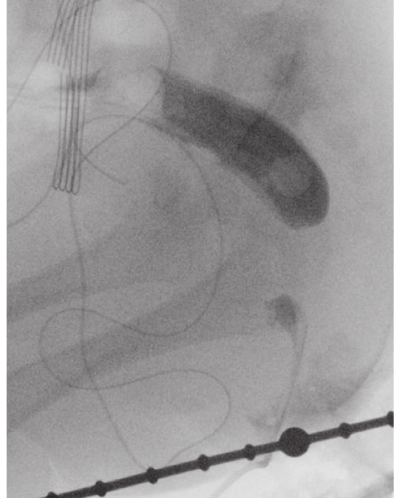
Figure 3: A cologram showed a distance of 2cm between the rectal endings.